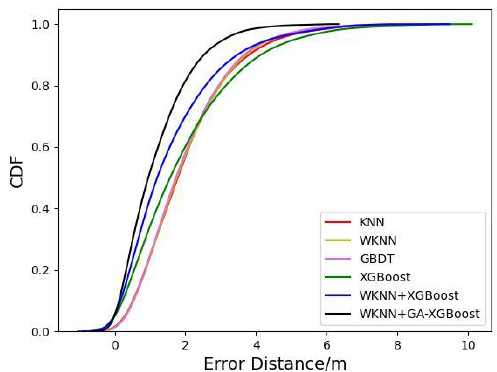
Figure 9. Cumulative probability distribution diagram .